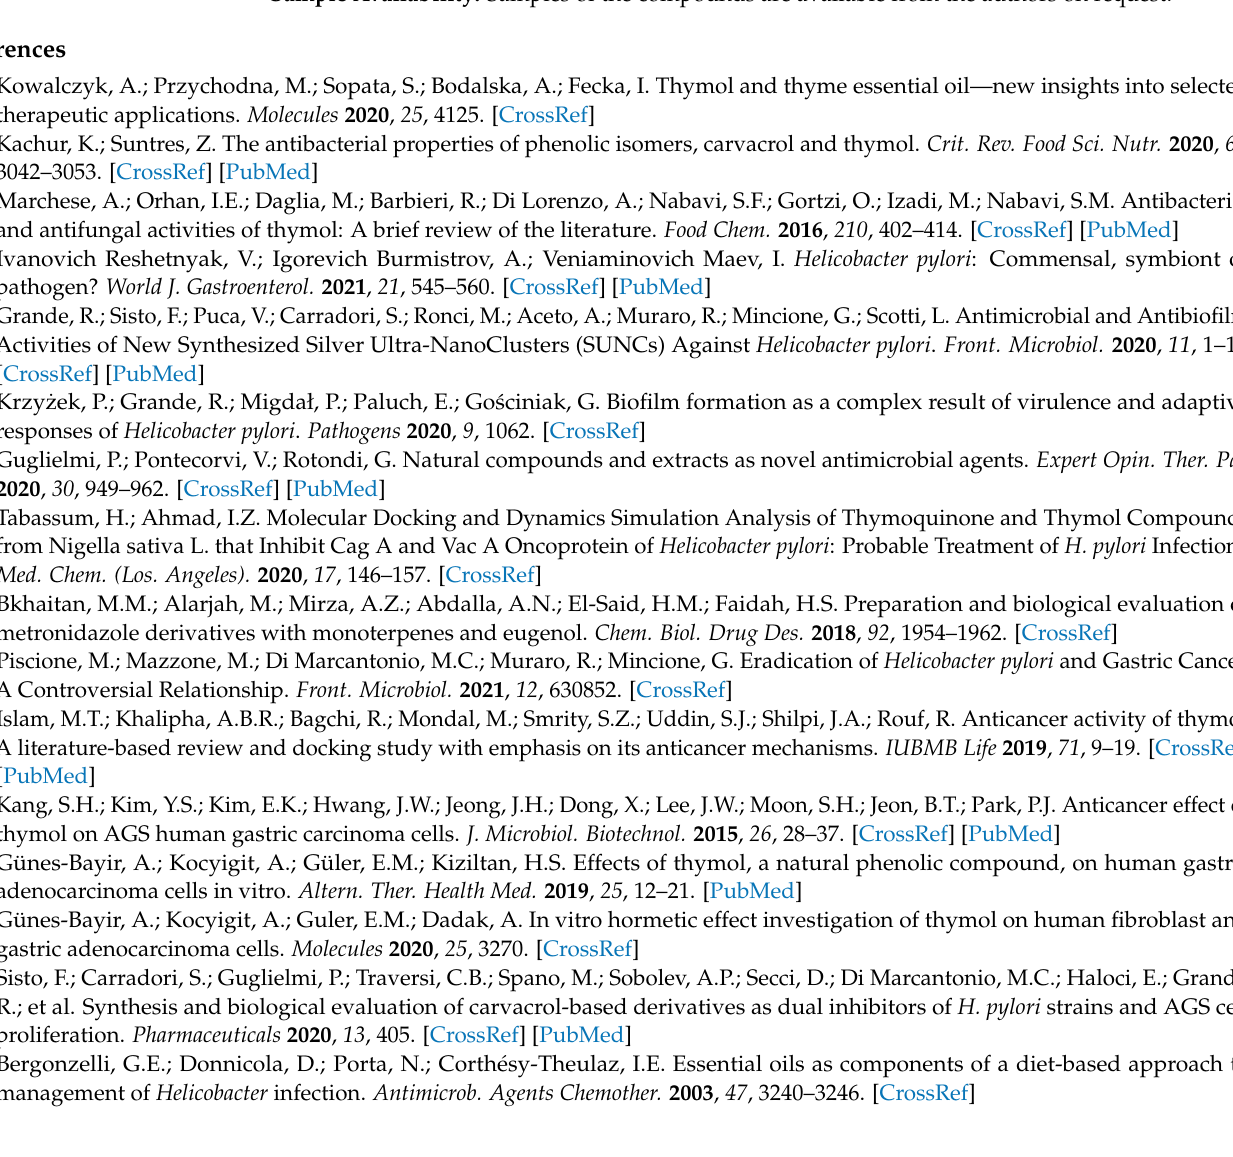
Supplementary Materials: The following are available online. Figure S1: NMR 19 F spectrum at 564.7 MHz of 20 in CDCl 3 . Figure S2: NMR 19 F spectrum at 564.7 MHz of 21 in CDCl 3 . Figure S3: NMR 19 F spectrum at 564.7 MHz of 22 in CDCl 3 . Figure S4: NMR 19 F spectrum at 564.7 MHz of 23 in CDCl 3 . Figure S5: NMR 19 F spectrum at 564.7 MHz of 25 in CDCl 3 . Figure S6: NMR 19 F spectrum at 564.7 MHz of 26 in CDCl 3 . Figure S7: NMR 19 F spectrum at 564.7 MHz of 27 in CDCl 3